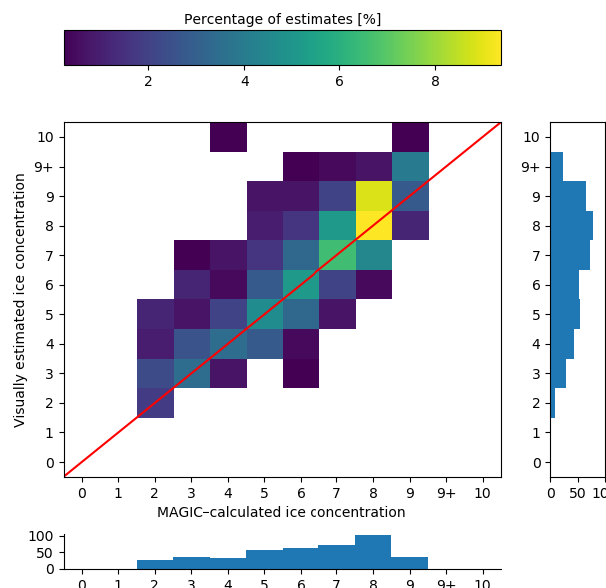
Figure 10. As in Fig. 7 but reduced to only validated polygons (i.e. analysts indicated that the segmentation results from MAGIC ade- quately segmented the ice from open